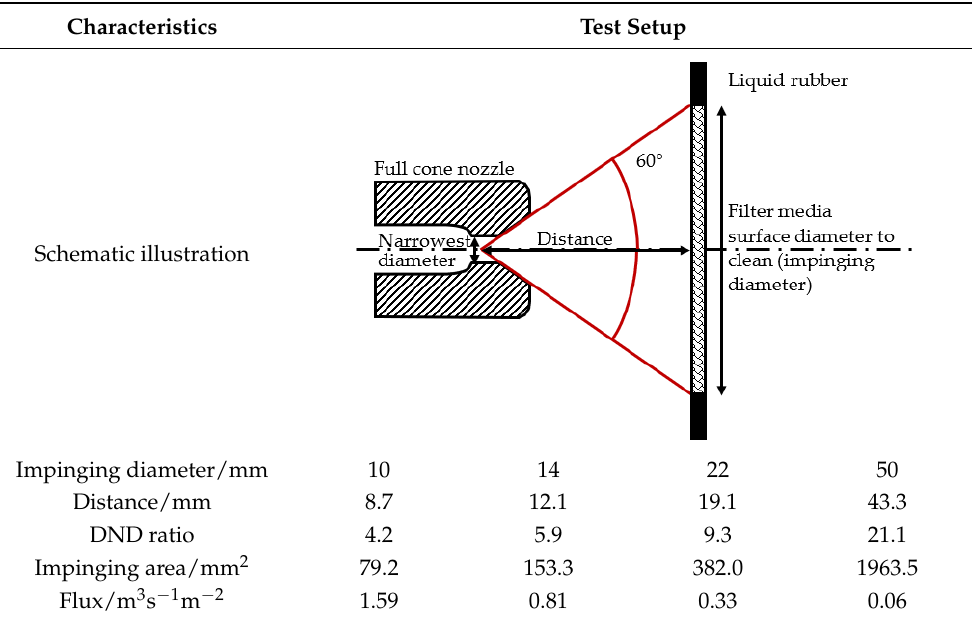
Table 4. Characteristics of the full cone nozzle, filter cloth sample positions and impinging areas.